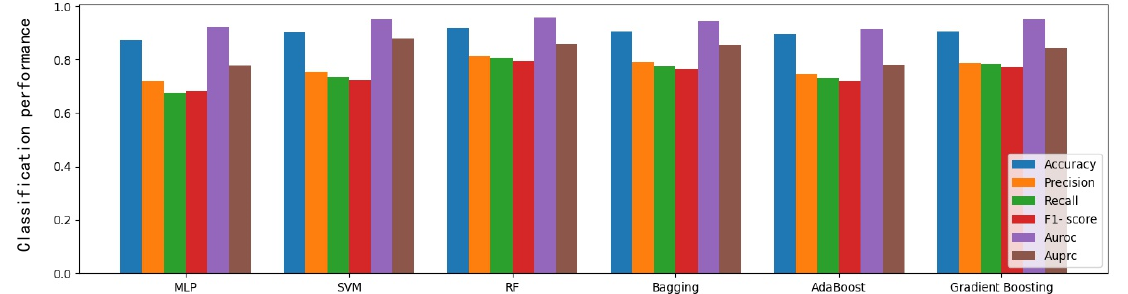
Figure 9. Other performance metrics for six classifiers using stratified K-fold cross-validation.